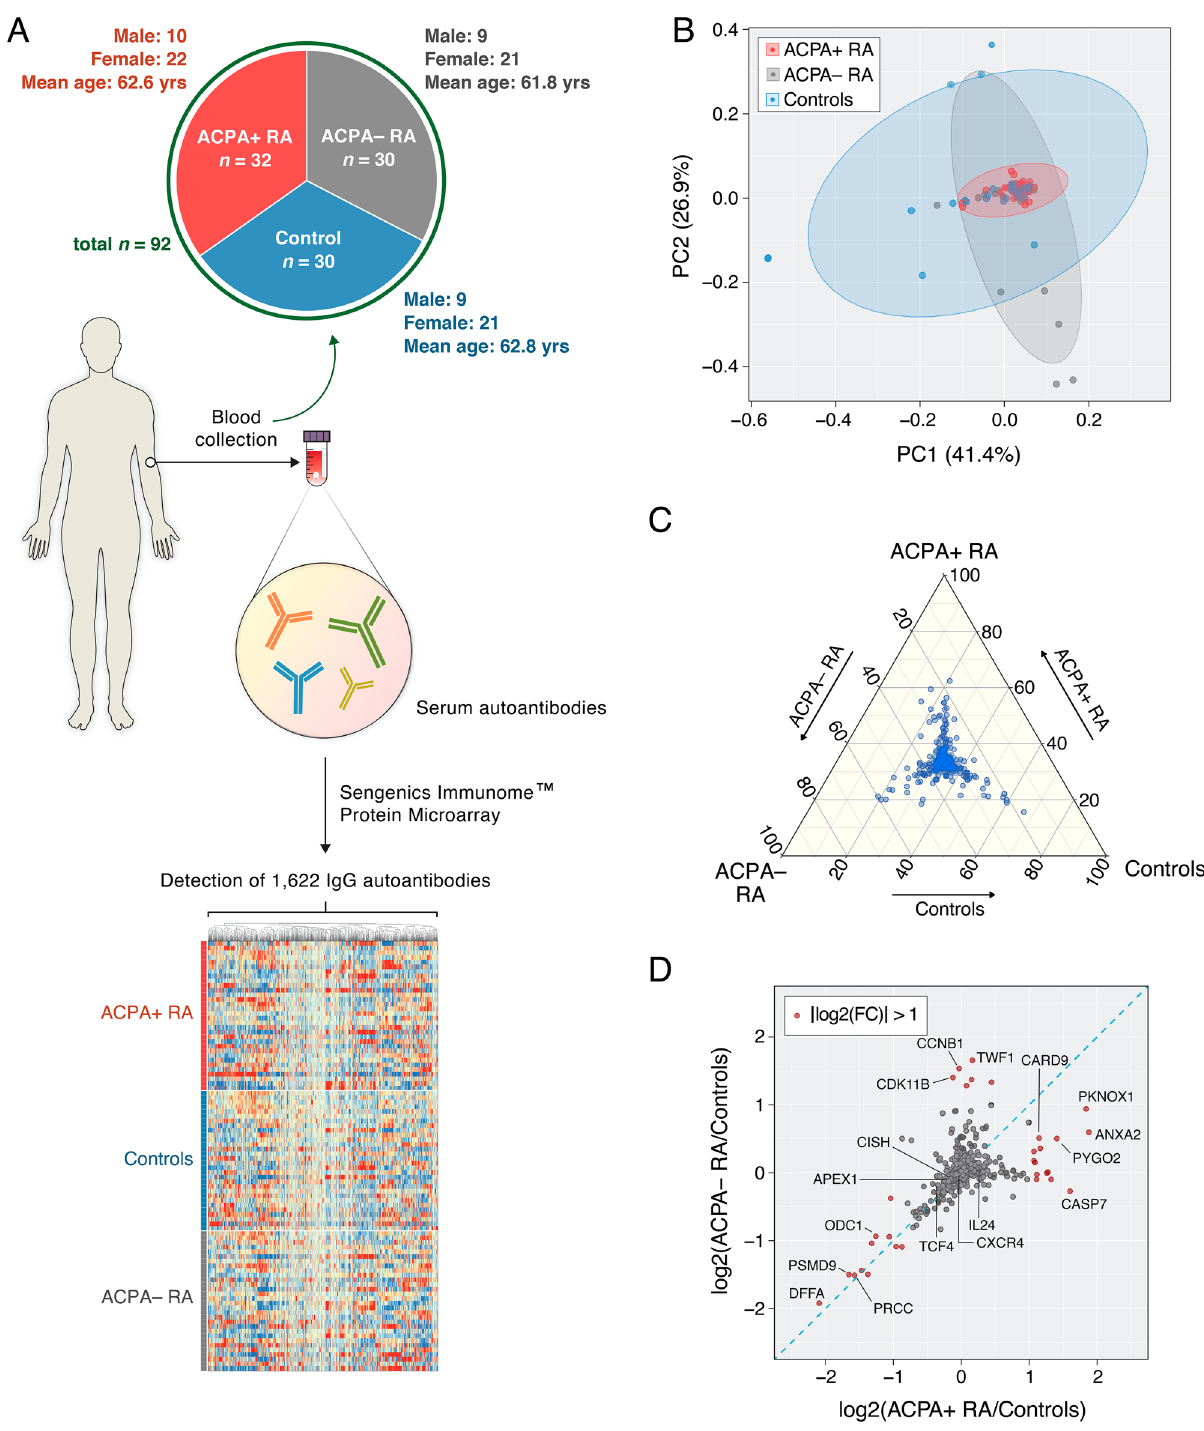
Figure 1. Group-wise comparisons of serum autoantibody composition profiles. ( A ) Blood (serum) samples were collected to examine autoantibody compositions in ACPA+ RA ( n = 32), ACPA− RA ( n = 30), and healthy controls ( n = 30). By using the Sengenics Immunome Protein Microarray, each serum sample was screened for 1622 IgG isotype autoantibodies that target human proteins in their full-length, correctly folded, native conformations. The heatmap illustrates autoantibodies clustered according to abundance similarities across samples. ( B ) Ordination plot (PCA) of the autoantibody profiles. ( C ) Ternary plot showing normalized mean abundances of 1622 autoantibodies across ACPA+ RA, ACPA− RA, and controls. The coordinates of each point correspond to normalized mean abundances (in percentages) and sum to 100. ( D ) Fold-changes in mean autoantibody abundances between an RA subgroup and the control group. X-axis and y-axis correspond to the fold-changes between ACPA+ RA and controls and between ACPA− RA and controls, respectively. Points shown in red represent autoantibodies that have a fold-change of 2 (or greater) between an RA subgroup and controls. The blue diagonal dashed line represents the line y = x. For brevity, the points in the scatterplot are labeled by the names of the autoantigen